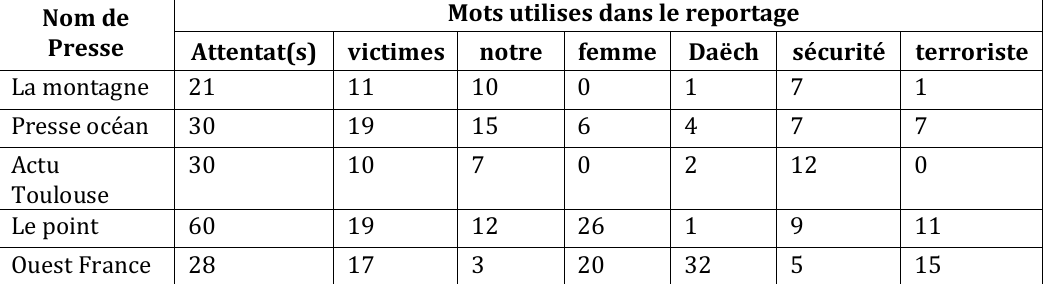
Tableu 1 Les lexiques choisis dans les